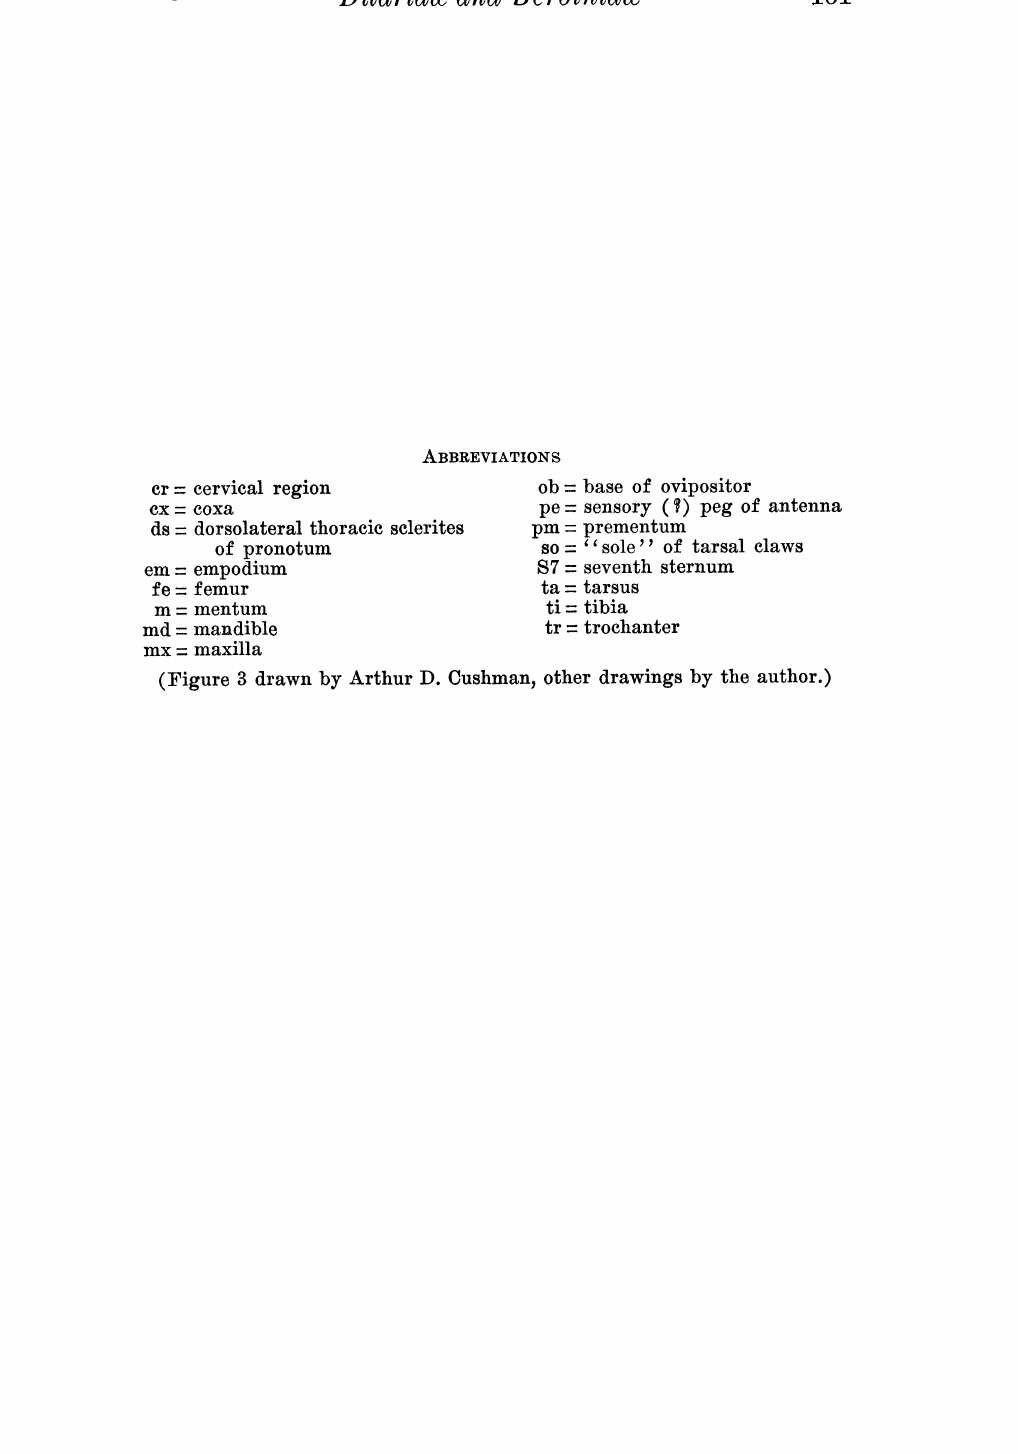
(Figure 3 drawn by Arthur D. Cushman, other drawings by the